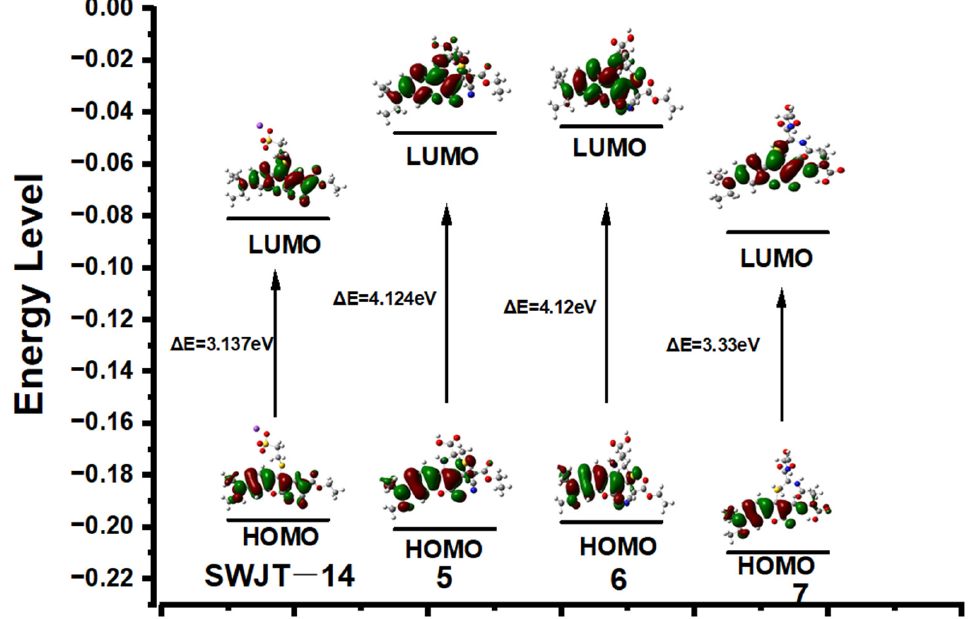
Figure 4 . Energy levels and optimized structure of SWJT-14 , 5 , 6 and 7 . Figure 4. Energy levels and optimized structure of SWJT-14 , 5 , 6 and 7